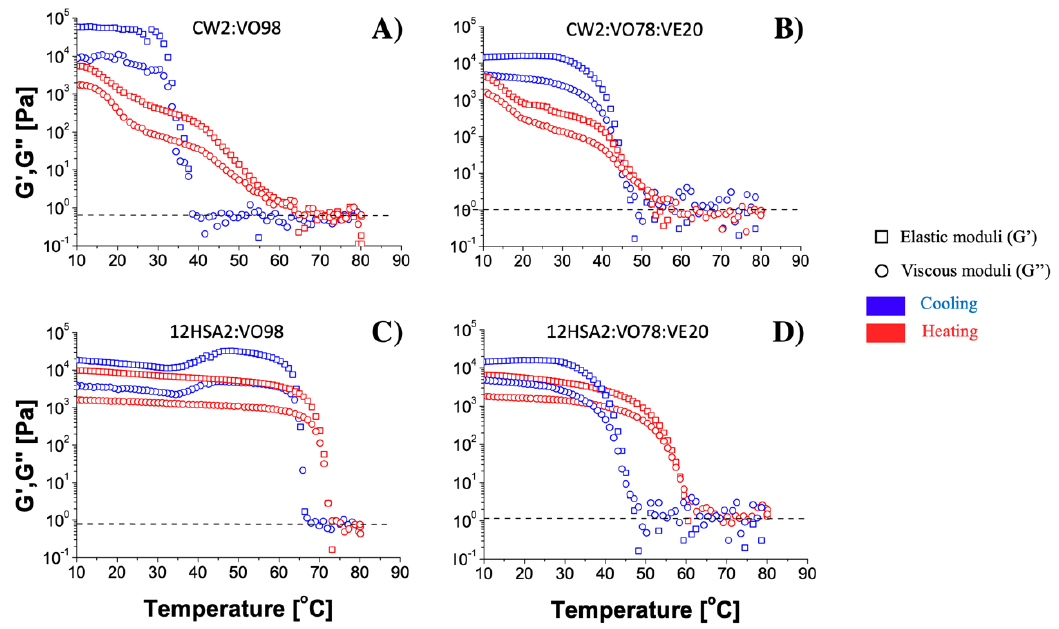
Figure 4. Temperature ramp test results for CW2:VO98 ( A ), CW2:VO78:VE20 ( B ), 12HSA2:VO98 ( C ), and 12HSA2:VO78:VE20 ( D ) organogels. In Table 1, the organogel melting temperature and the gelation transition temperature obtained from the ramps where G′ ≈ G′′ are presented.